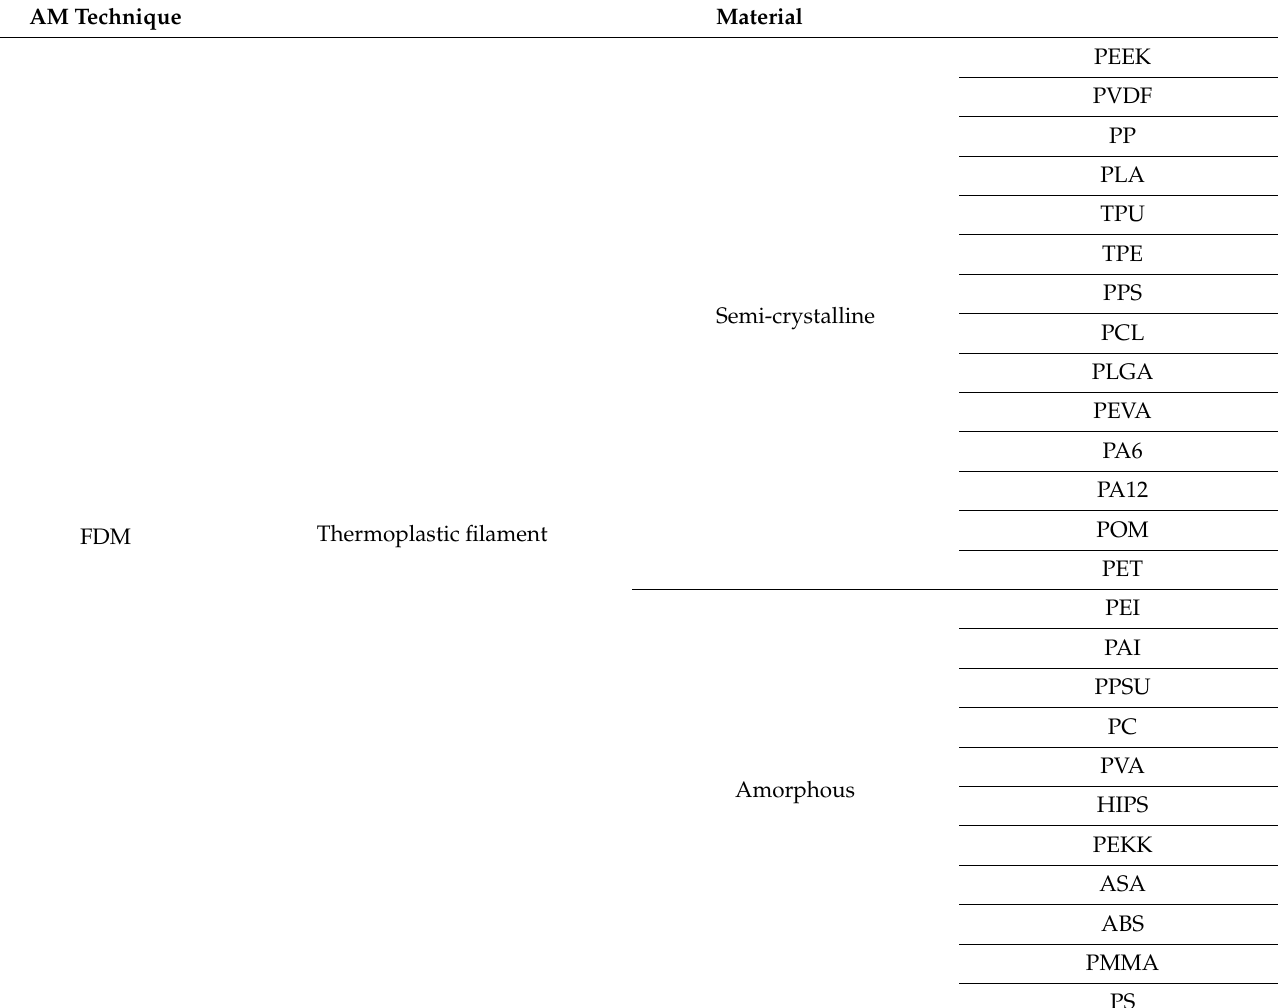
Table 2. A general classification of available materials (commercial and laboratory-grade) for FDM, SLS, and SLA printing. AM